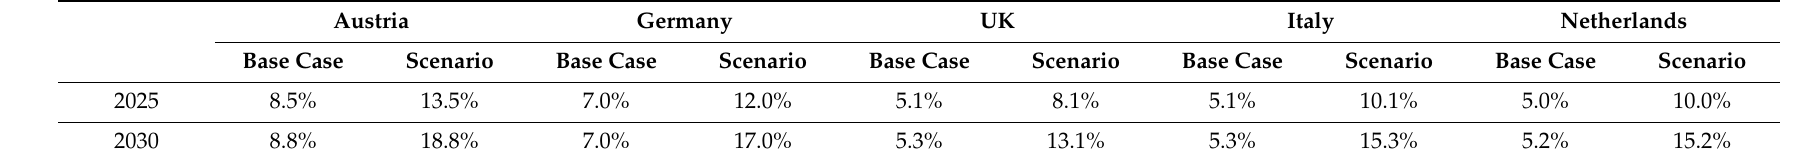
Table 5. Share of